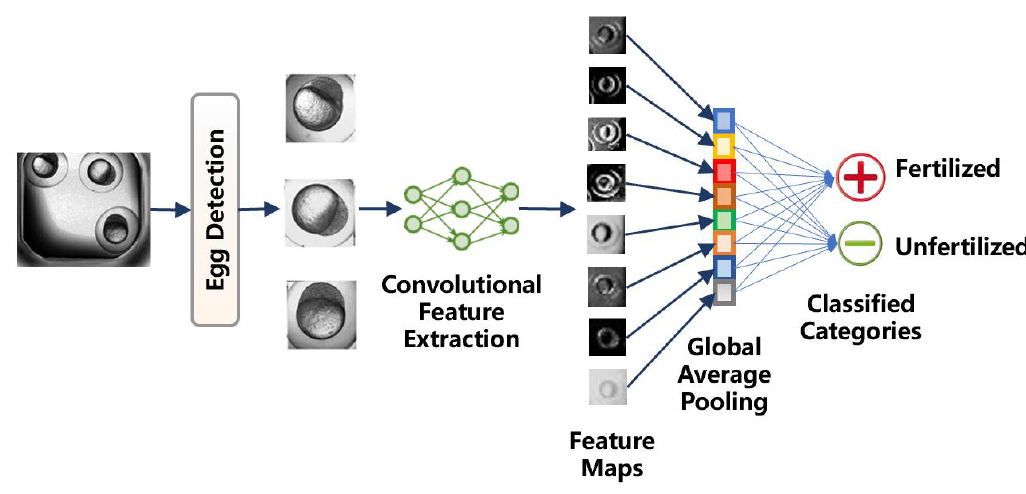
Figure 2. The workflow of the proposed method.